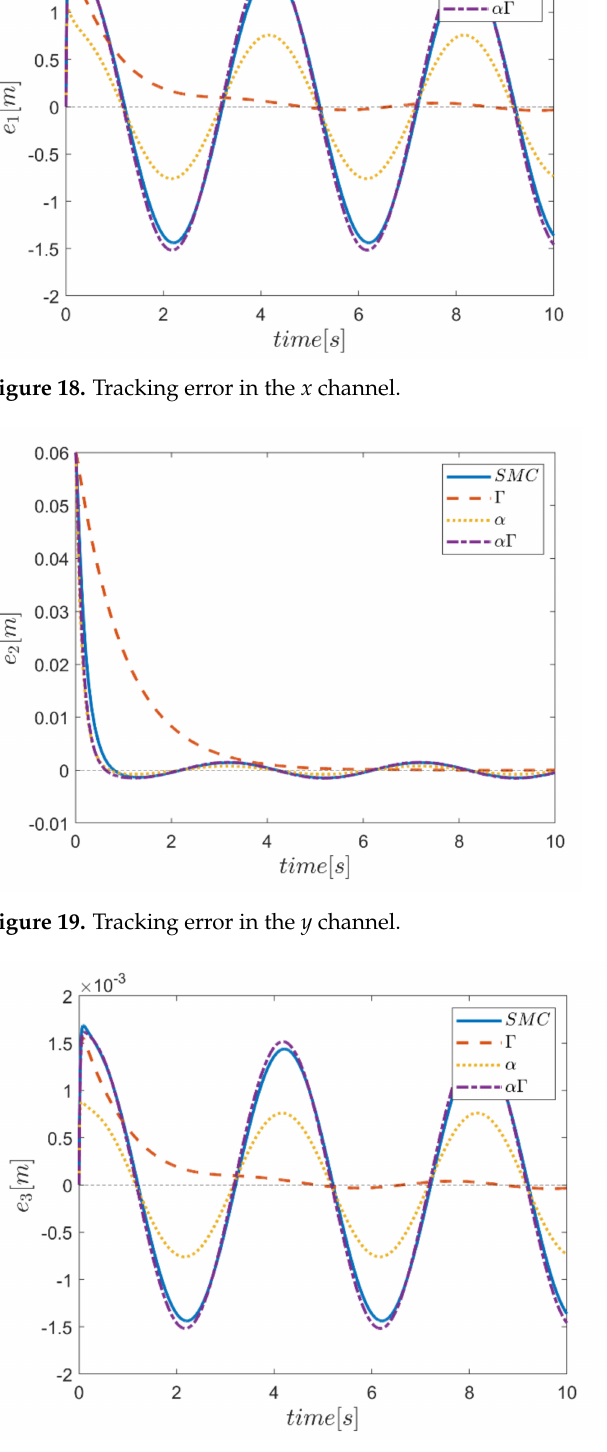
Figure 20. Tracking error in z